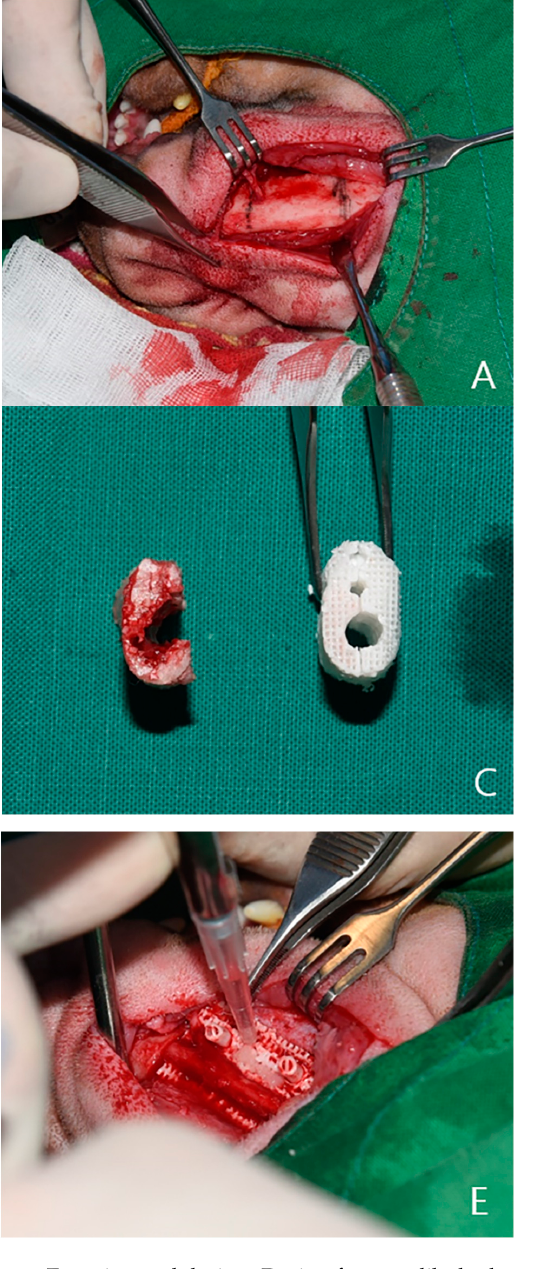
Figure 8. Experimental design. Design for mandibular bone defect of beagle model ( A ) after the defect was kept empty ( B ); PCL/TCP/bdECM 3D printing model ( C ); fibrin glue seeding after adipose-derived stem cells (ADSCs) was applied ( D , E ); fixed by plate and screw ( F ).